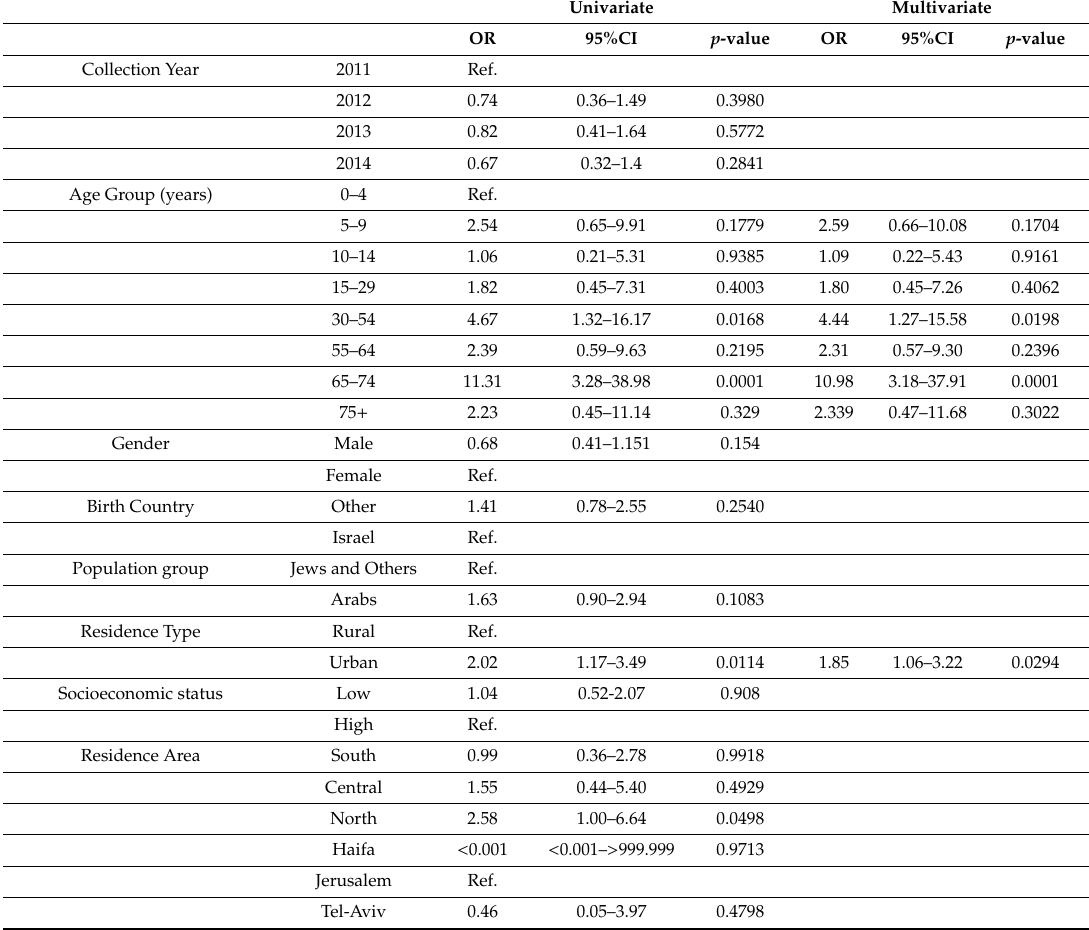
Table 3. Univariate and multivariate logistic regression analyses of demographic characteristics of individuals diagnosed with Sindbis virus by SINV